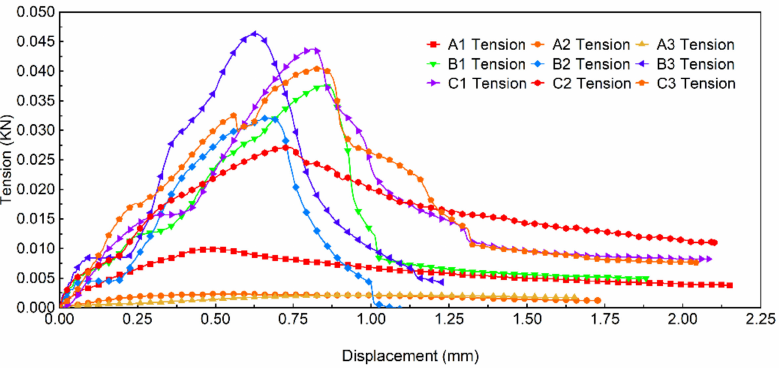
Figure 12. Variation curve of force and displacement before and after sample breaking.